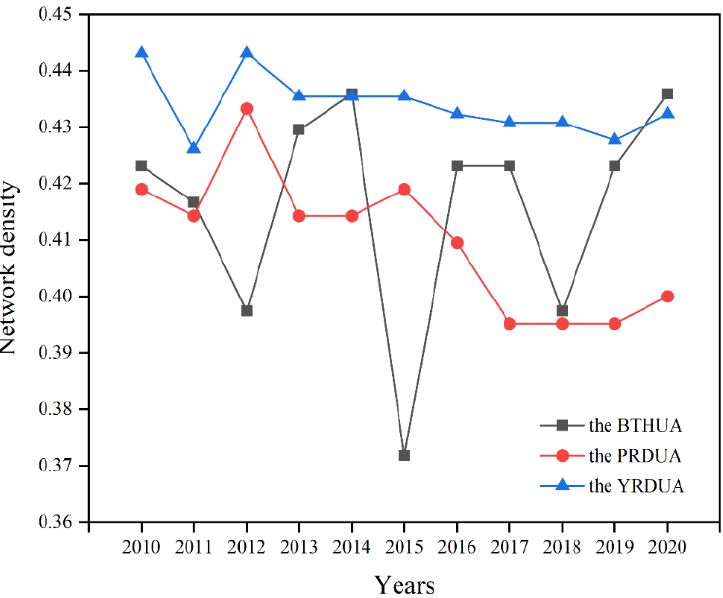
Figure 4. Network density of the housing prices’ association network in the BTHUA, the PRDUA, and the YRDUA from 2010 to 2020.